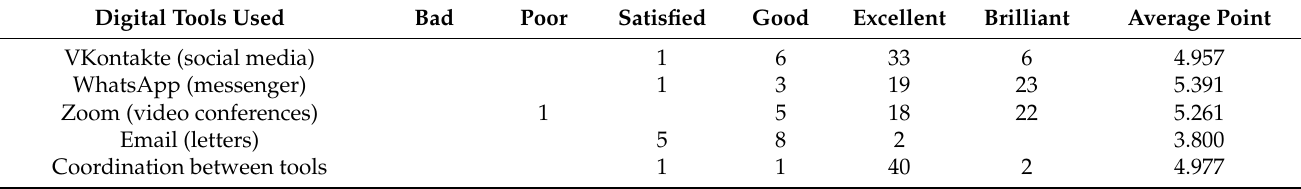
Digital Tools Used Bad